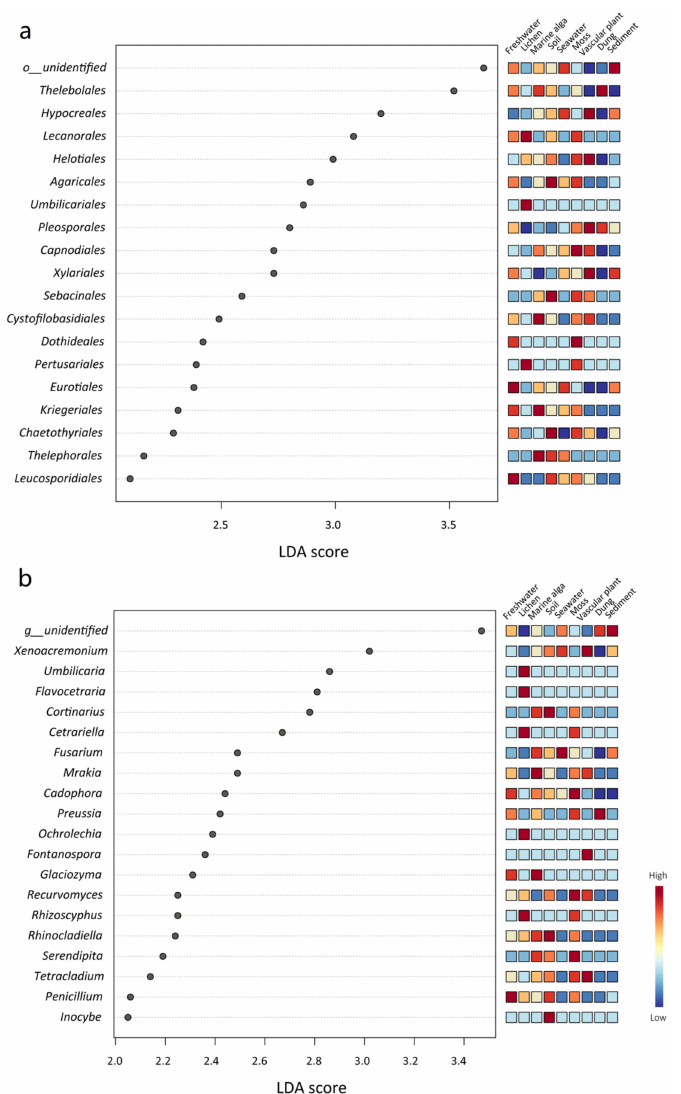
Figure 5. LEfSe analysis showing ( a ) the fungal orders and ( b ) the genera that differed significantly among the nine habitat types. The mini heatmap to the right of the plot indicates whether the taxa are higher (red) or lower (blue) in each